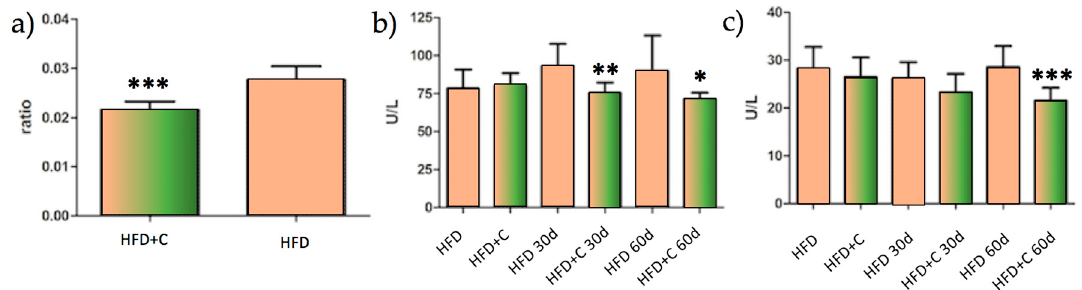
Figure 3. ( a ) Liver-to-body-weight ratio comparison between HFD and HFD + C groups; ( b ) HFD and HFD + C groups comparison of AST and ( c ) ALT transaminase at the beginning, and 30 and 60 days after the experiment. Stars indicate that the values were significantly different ( p < 0.05 with *, p < 0.01 with **, and p < 0.001 with ***, mean ± SD n = 10).